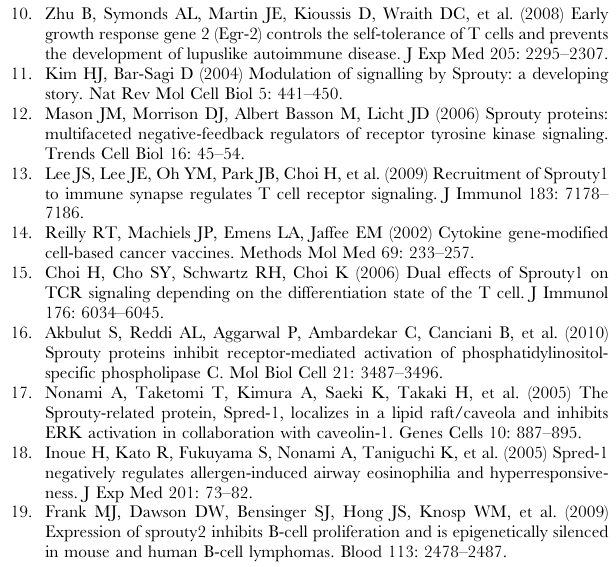
Figure S1 Spry1 is recruited to the cSMAC. 5C.C7 T cells were incubated with peptide for 20 minutes, permeabilized and stained using anti-Talin and anti-Spry1 antibodies. Upper left shows a T cell-APC conjugate. Talin (green) is shown to delineate the pSMAC. Spry1 (red) mobilizes to the cSMAC region. Note, Spry1 is diffusely expressed in the APC. In the bottom panel the image is rotated to show the contact view. The green defines the pSMAC while the red clearly demonstrates Spry1 in the cSMAC region. (TIF) Figure S2 Schematic of Wt and mutated Spry1 con- structs. (TIF) Figure S3 Expression of Spry1 and mutated Spry1. Western blot analysis of transfected Jurkat cells with either the empty vector, DC104 Spry1 (mutated) and full length Spry1. Note the antibody recognizes the endogenous Spry1 as well as a lower molecular weight form of the mutated